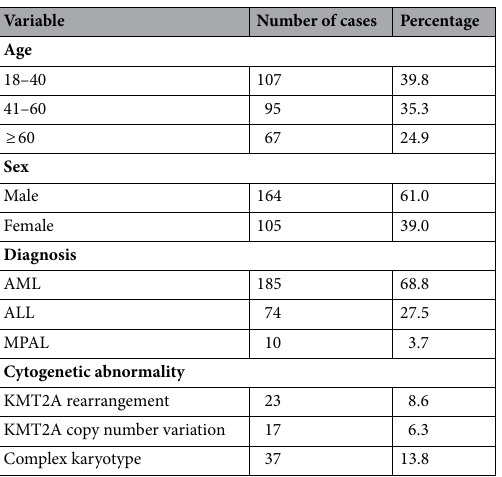
Table 1. The clinical and pathological features of the 269 AL patients.